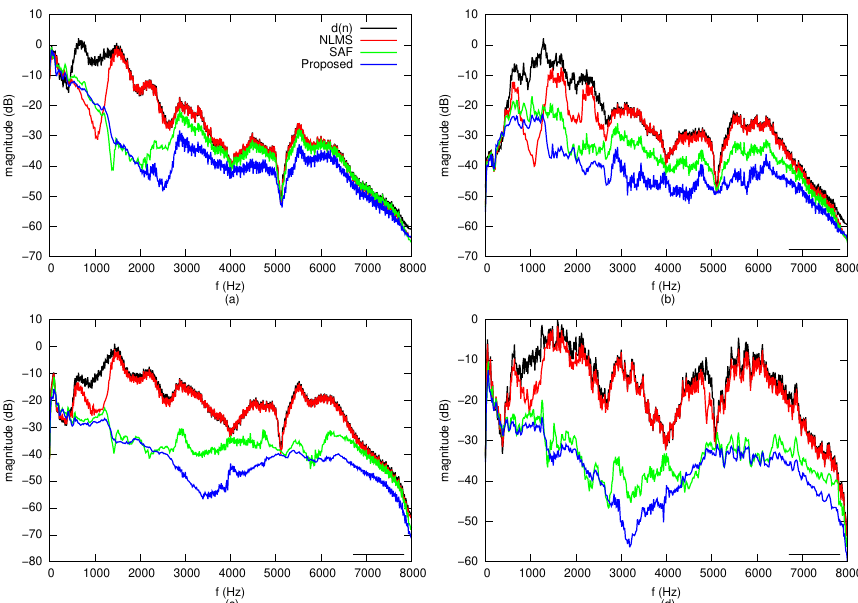
Figure 12. Test case 3: spectrum for noise to reduce d ( n ) and residual signal e ( n ) . The reference signal is aircraft noise ( a ), kindergarten noise ( b ), outside traffic road ( c ) and jack-hammer ( d ). The legend is the same for all sub